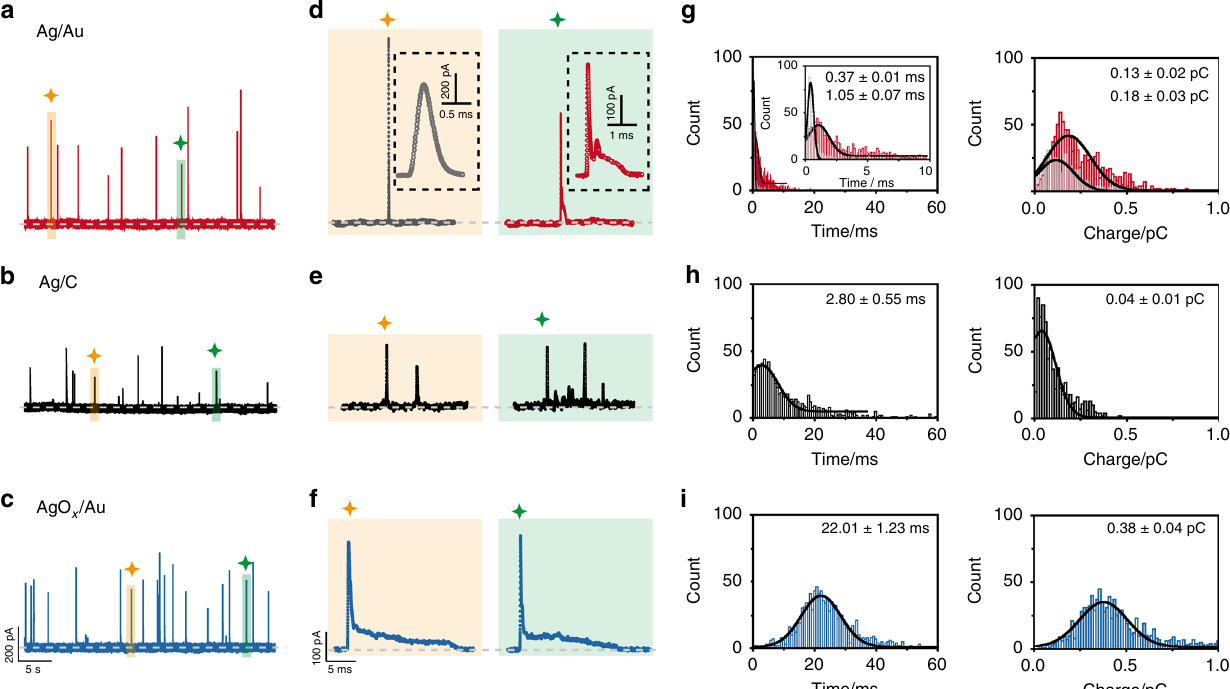
Fig. 2 Interaction-modulated dynamic electrochemical oxidation behaviors of single AgNPs. Current responses of individual 34 nm AgNPs collisions at + 600 mV vs. Ag/AgCl a in neutral solution (25 mM PB, pH = 7.4, red line) at an Au UME (diameter 12.5 μ m), b in neutral solution (25 mM PB, pH = 7.4, black line) at a C UME (diameter 7 μ m), and c in alkaline media (15 mM PB and 10 mM NaOH, pH = 11.4, blue line) at an Au UME (diameter 12.5 μ m). a – c Chronoamperometric pro fi les for the electrochemical oxidation of individual AgNPs with the same scale bar. d – f Close-ups of the representative time- resolved current traces, corresponding to the spikes in a – c . Inset: zoom-in of the corresponding current traces. g – i Histograms showing the distributions of the durations and charges of AgNPs. Black curves show Gaussian fi ts. The data were obtained from a large population of electrooxidation events of individual AgNPs (more than 1000 events). Source data are provided as a Source Data fi